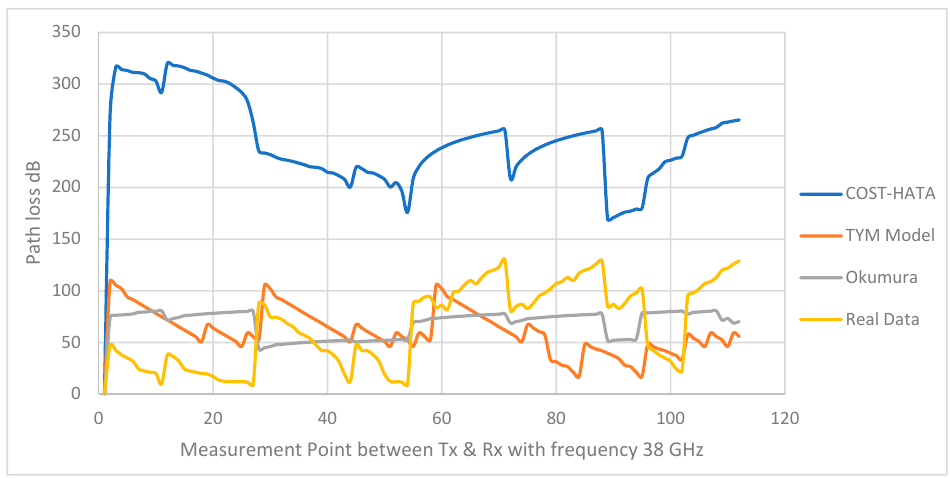
Figure 10. Comparison between the TYM model and the other models with a frequency of 38 GHz.